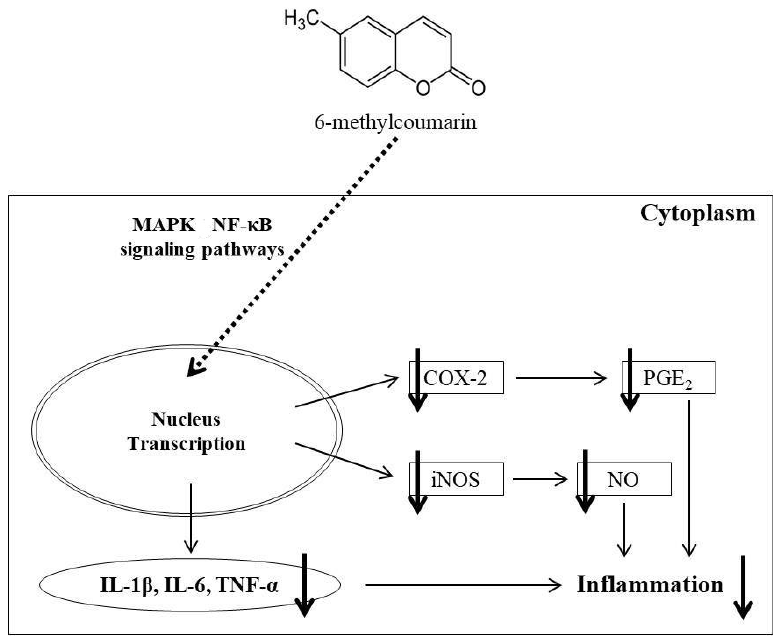
Figure 9. 6-MC induces anti-inflammatory effects by inhibiting the production of inflammatory mediators (NO and PGE 2 ) and pro-inflammatory cytokines (IL-1β, IL-6, and TNF-α) via MAPK and mediators (NO and PGE 2 ) and pro-inflammatory cytokines (IL-1 β , IL-6, and TNF- α ) via MAPK and NF-κB signaling pathways in the cells treated with LPS. NF- κ B signaling pathways in the cells treated with